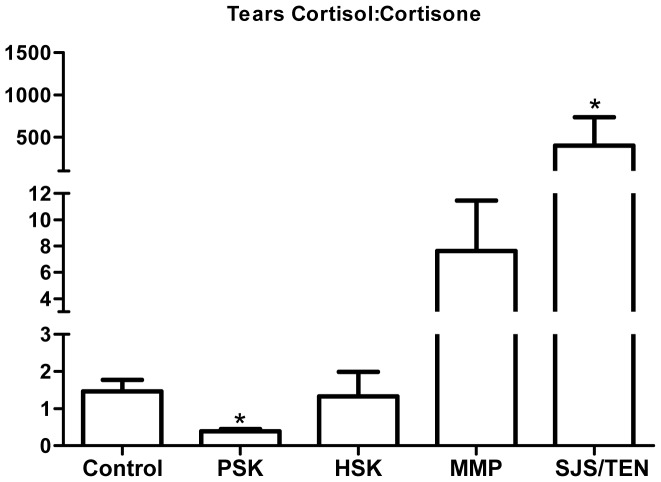
Ocular surface glucocorticoid bioavailability in health and disease.Evaluation of tear film glucocorticoid profiles as surrogate readouts of net ocular surface glucocorticoid bioavailability, defines cortisol depletion (reduced cortisol∶cortisone (F∶E ratio, mean±SE) during active untreated pseudomonas keratitis (PSK) but not herpes simplex keratitis (HSK), and amplification during chronic clinically quiescent immune-mediated disease (MMP, mucous membrane pemphigoid; SJS/TEN, Stevens-Johnson Syndrome/Toxic-epidermal Necrolysis). Statistical analysis performed using t-test with two-tailed Mann Whitney post -test. * = P<0.05.